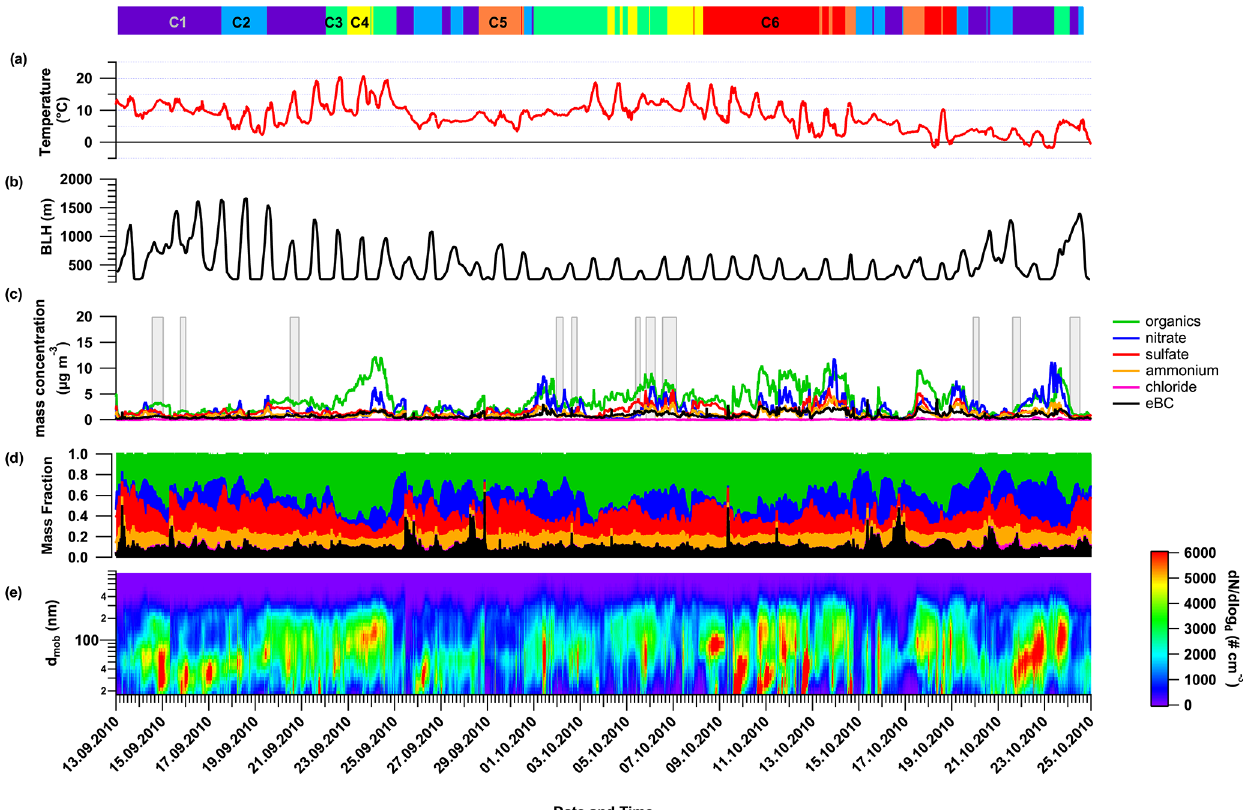
Figure 1. Time series of the ambient temperature (a) , estimated boundary layer height (BLH) obtained from HYSPLIT GDAS input (b) , the particulate near-PM 1 chemical composition as measured by the AMS and completed by MAAP for equivalent black carbon (c) , the corresponding mass fraction (d) , and the particle number size distribution (e) during HCCT-2010 at the site of Goldlauter. The colored bars and numbers at the top refer to the six different air mass clusters (see Sect. 3.4), and the gray bars refer to the different cloud and non-cloud events, as defined in Table